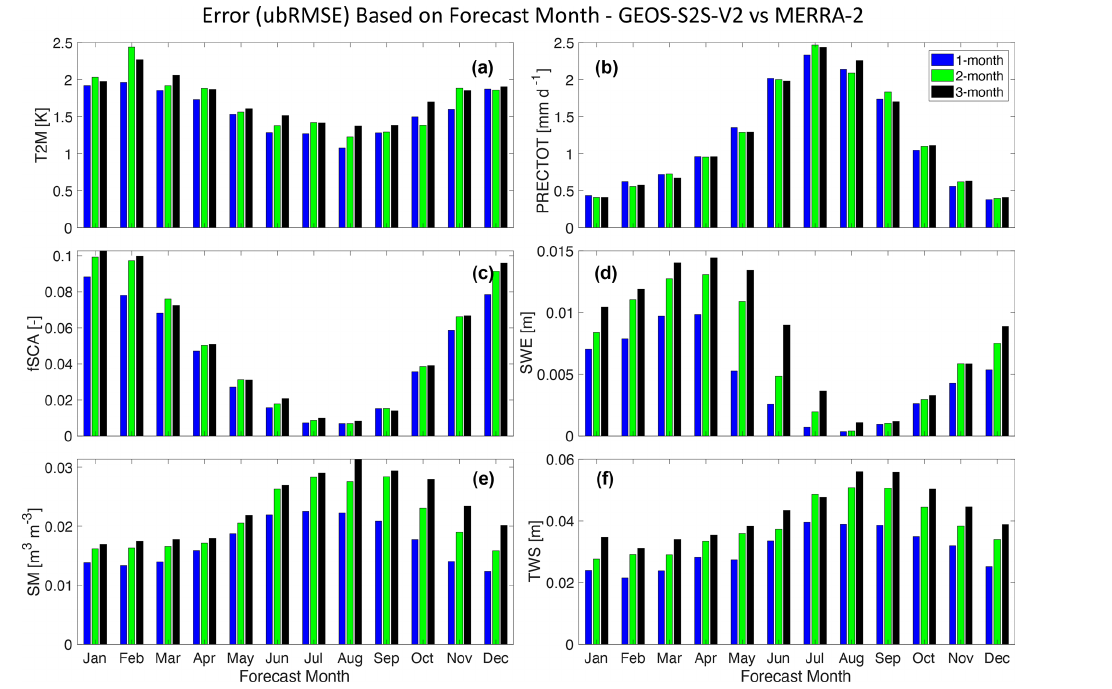
Figure 5. The expected error (ubRMSE) based on which month is forecasted. Shown here are results for 1-month (blue, first bar), 2-month (green, second bar), and 3-month (black, third bar) lead times for each variable. For example, the three bars for the month of April include the 1-month, 2-month, and 3-month forecasts, which are the forecasts initialized in March, February, and January respectively. The results displayed in this figure use MERRA-2 as the evaluation